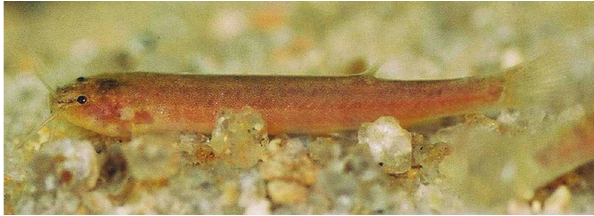
Fig. 7. Trichomycterus payaya , living specimens photographed in a field aquarium shortly after collection. Photo by O. T.